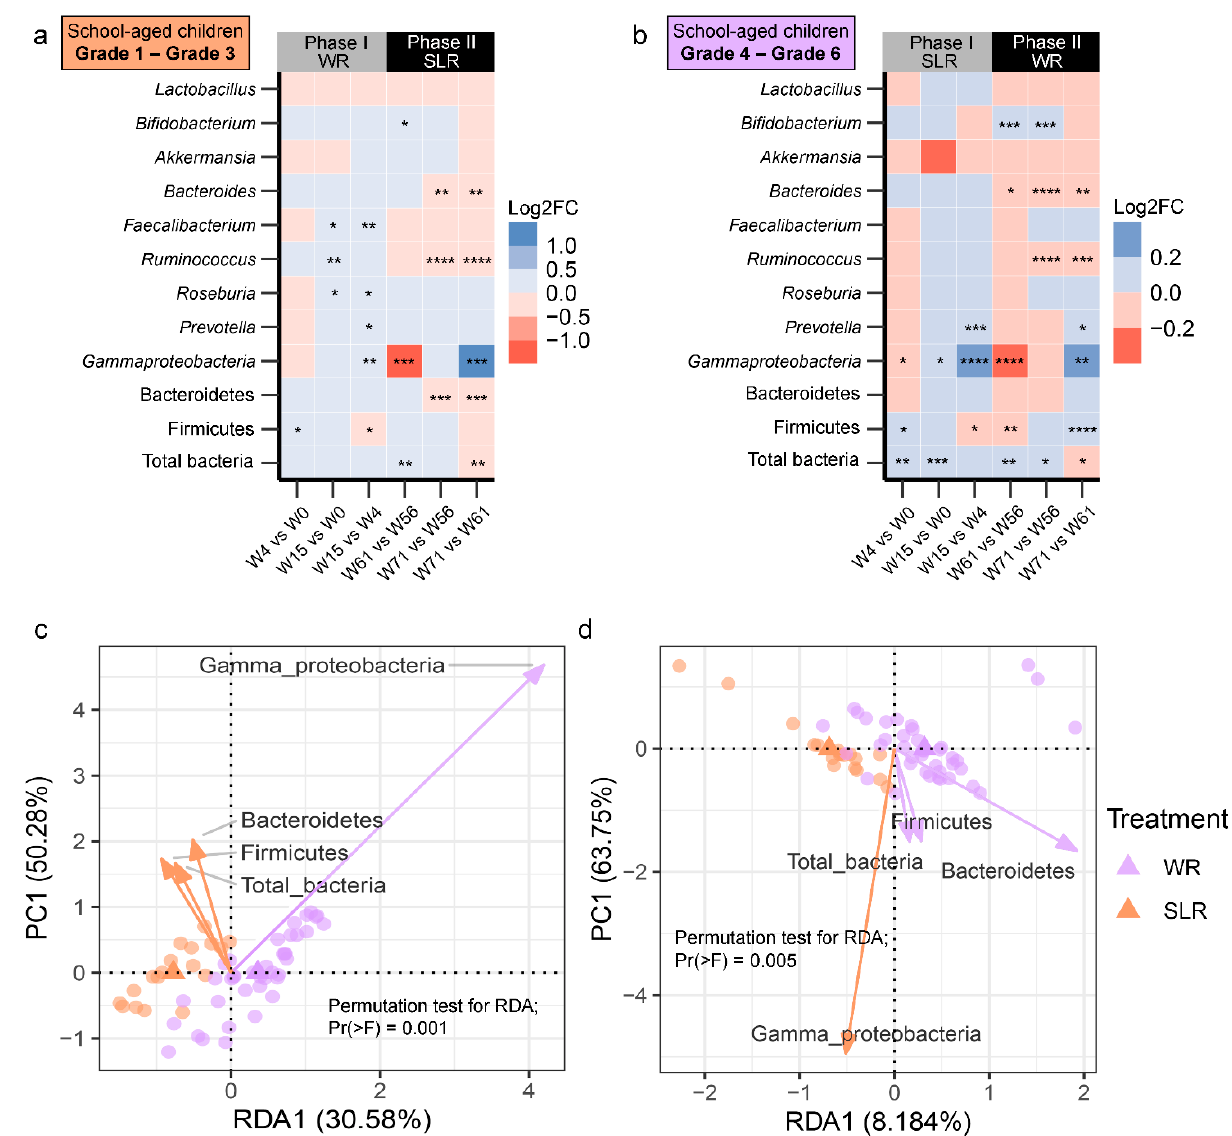
Figure 3. Differentially abundant gut microbiota across the weeks of intervention. ( a , b ) Heat plots showing the log2 fold change calculated based on the absolute abundances of gut microbiota between the weeks of the SLR intervention. Red indicates cases where the log2 fold change values were negative. Blue indicates cases where the log2 fold change values were positive. Differences in the mean absolute abundances of gut microbiota between the weeks were determined using either pairwise t -tests or Wilcoxon signed rank tests with Benjamini-Hochberg (BH) p -value correction following significant results from a one-way repeated measures ANOVA or the Friedman test ( p < 0.05). **** q < 0.0001, *** q < 0.001, ** q < 0.01, * q < 0.05. ( c , d ) RDA plots for gut microbiota analysis using treatments at Week 61 ( c ) and Week 71 ( d ). Treatments (WR and SLR) were used as constrained explanatory variables and the absolute abundances of gut microbiota were used as response variables. Orange dots represent the control group (WR treatment), and blue dots represent the intervention group (SLR treatment). An orange triangle indicates the centroids of the WR group. A blue triangle indicates the centroids of the SLR group. Biplot arrows (gut microbiota) in the RDA plots of Week 61 and Week 71 were colored according to their associations with the treatment groups. The angle between a pair of vectors reflects their correlation. A significance of constraints was assessed using an ANOVA-like permutation test. WR, white rice (control); SLR, Sinlek rice intervention.